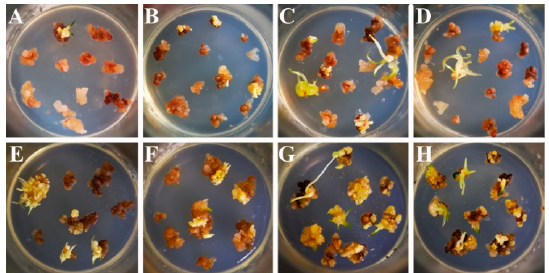
Figure 4. Resistant calli germination. ( A ) and ( E ), OE- LpABCB21 ; ( B ) and ( F ), OE- LpABCB7 ; ( C ) and ( G ), KO- LpABCB21 ; ( D ) and ( H ), KO- LpPILS7 . ( A – D ), Germination I condition; E–H, Germination II condition.